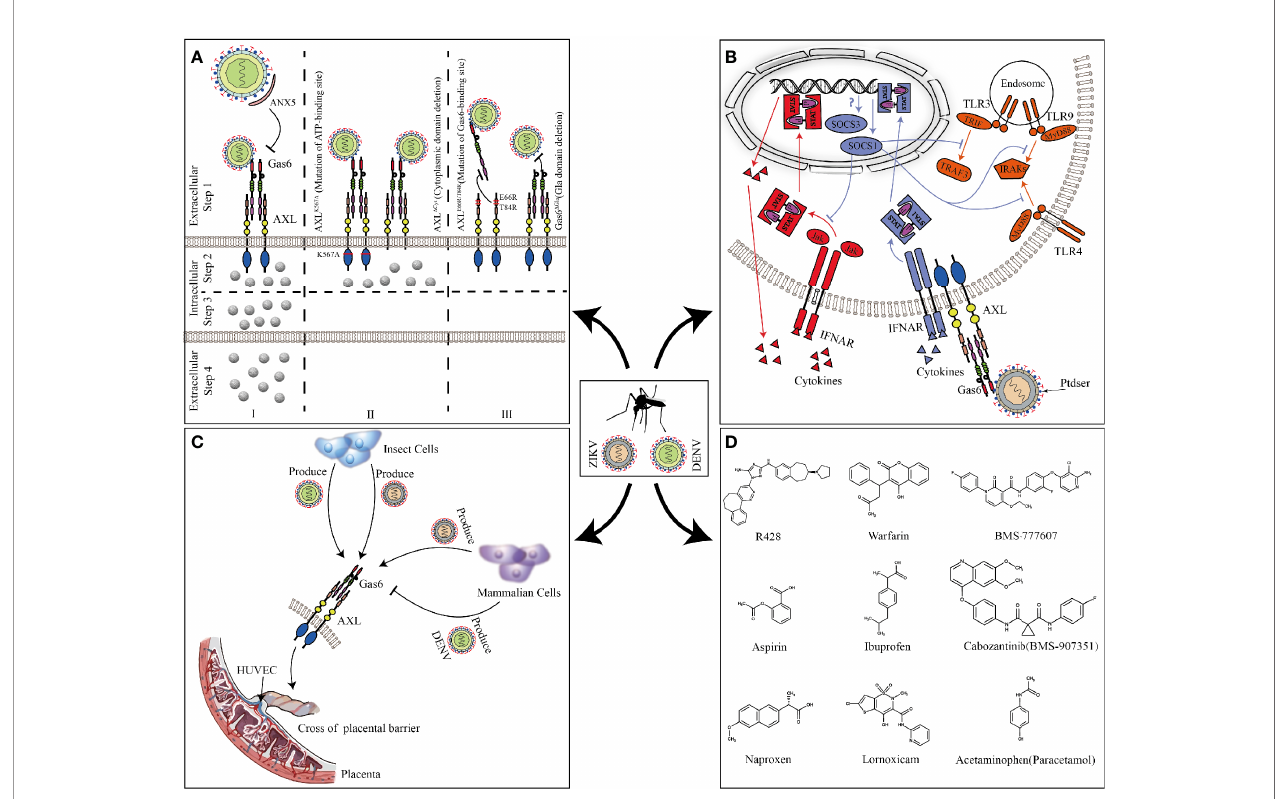
FIGURE 4 | AXL promotes ZIKV and DENV replication. (A) Full-length AXL promote DENV replication. ANX5 competitively binds PS, blocking the binding of DENV to Gas6 (zone I). AXL K567A and AXL D Cyt promote the binding and internalization of DENV (Zone II step2) but are unable to enhance DV infection (Zone II step3 and 4). Mutation of the Gas6 binding site in AXL can effectively inhibit DENV-Gas6 complex binding to AXL (zone III). (B) The feedback inhibition of the innate immune response to ZIKV. ZIKV-Gas6 complex activates AXL and up-regulates SOCS1 expression in a STAT1/STAT2-dependent manner (blue) to inhibit TLR signaling pathways and cytokine signaling (red). (C) ZIKV and DENV produced by insect cells or mammalian cells cross the placental barrier to infect HUVECs through AXL. (D) The chemical structure of the AXL inhibitors that have been reported to block ZIKV and DENV